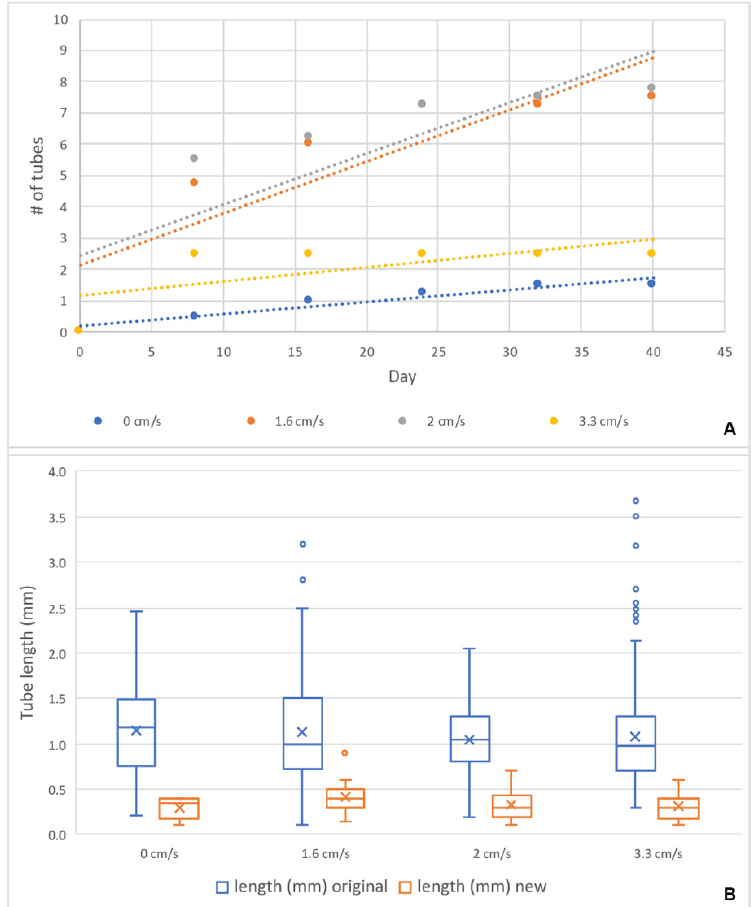
Figure 11. The number of tubes re-secreted and tube length with respect to flow velocity. ( A ) The number of new tubes built per day, grouped by flow velocity treatment, plotted together for comparison. Trend lines used the method of least squares to find the regression line. ( B ) Differences in tube length between the original tubes (blue) and the new tubes (orange) for each treatment. Each box delimits the distance between the first and third quartile, the median is the horizontal bar in the box, and the “×” is the mean value. The whiskers reach the lowest and largest data points, excluding the outliers (dots).